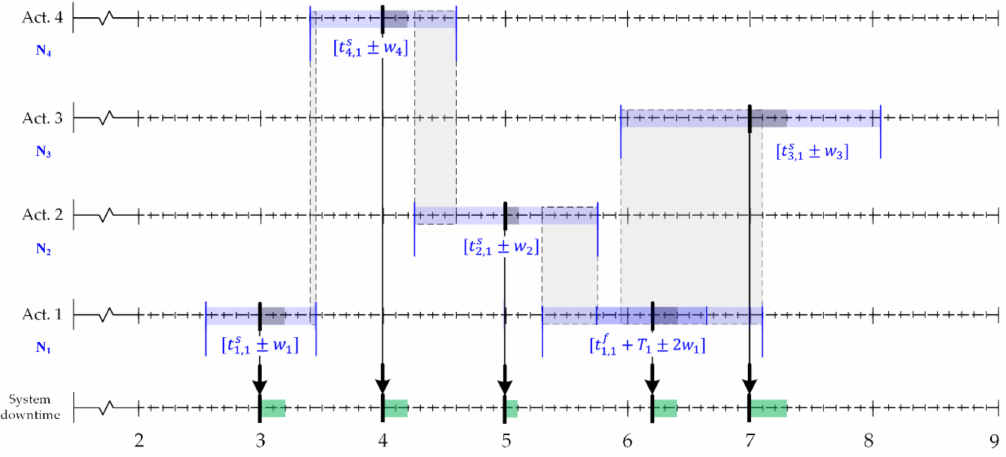
Figure 4. Representation of the use of tolerances for the generation of feasible grouping schemes.